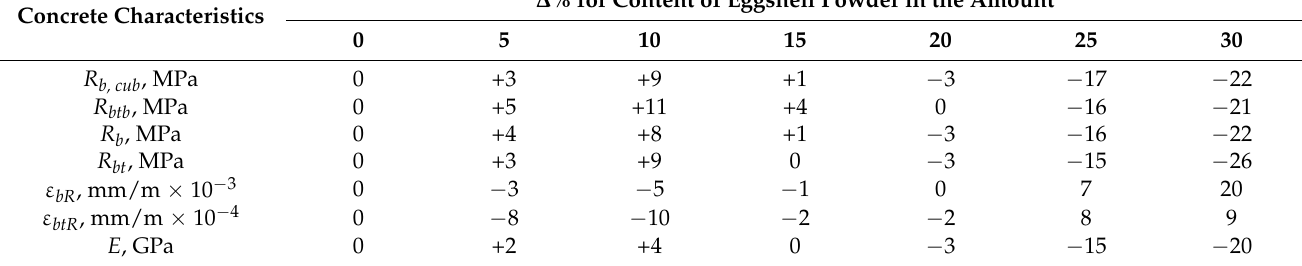
Table 11. Change in strength and deformation characteristics of concrete samples depending on the dosage of eggshell powder ( ∆ ).